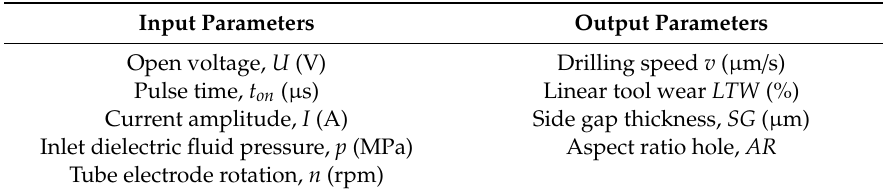
Table 4. Process parameters and their levels.